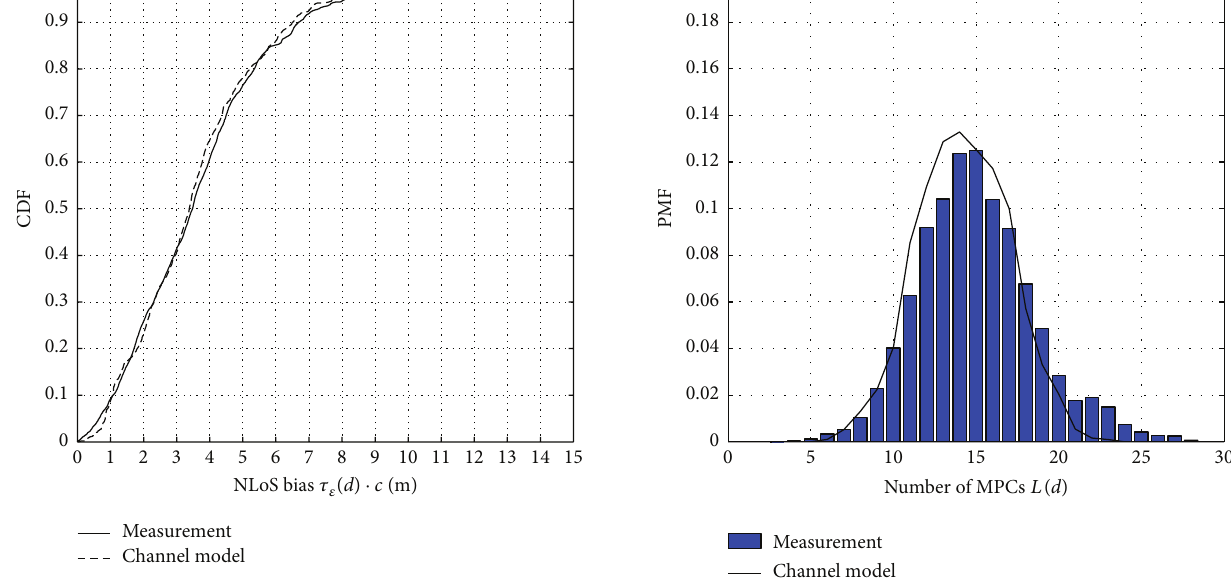
Figure 21: Comparison of the number of MPCs between measure- ment based estimation and channel model based simulation for